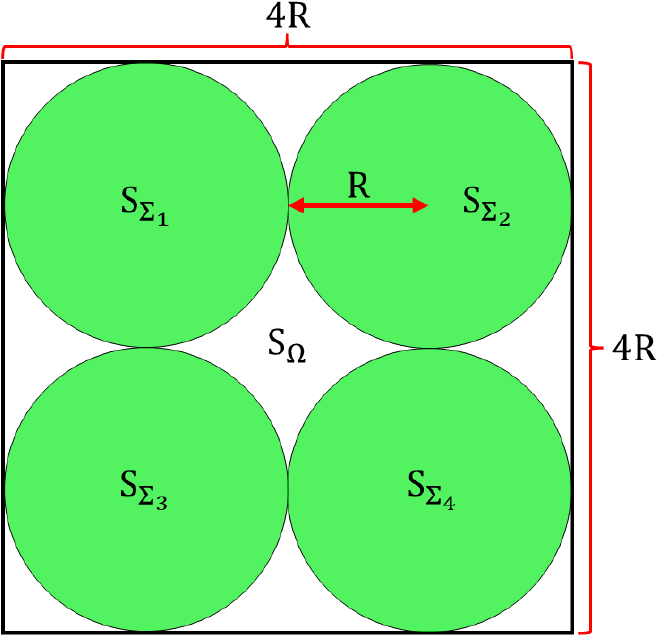
Figure 8. The scheme of the reference monitoring configuration. In the case of four fields of view ( n = 4), which is depicted in the scheme, the effectiveness of the covering is S Σ case of arbitrary number of the fields of view inscribed in the monitoring area, the effectiveness is also equal to the π /4, since S Σ